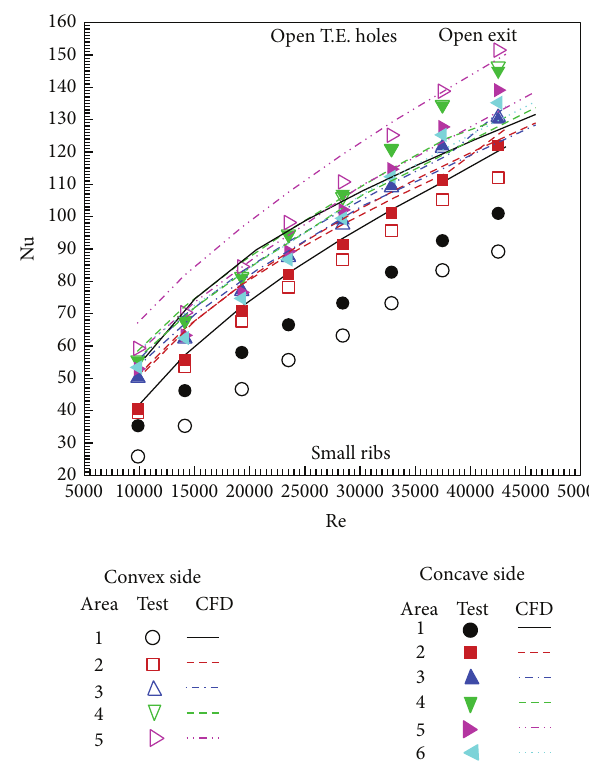
Figure 13: Comparison of the measured and CFD heat transfer results in the rib-roughened channel on the convex and concave walls for the case of open trailing-edge holes and open channel